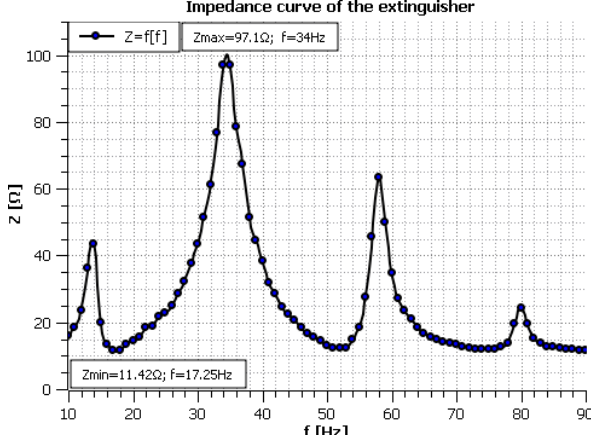
Figure 3: Impedance curve of the extinguisher